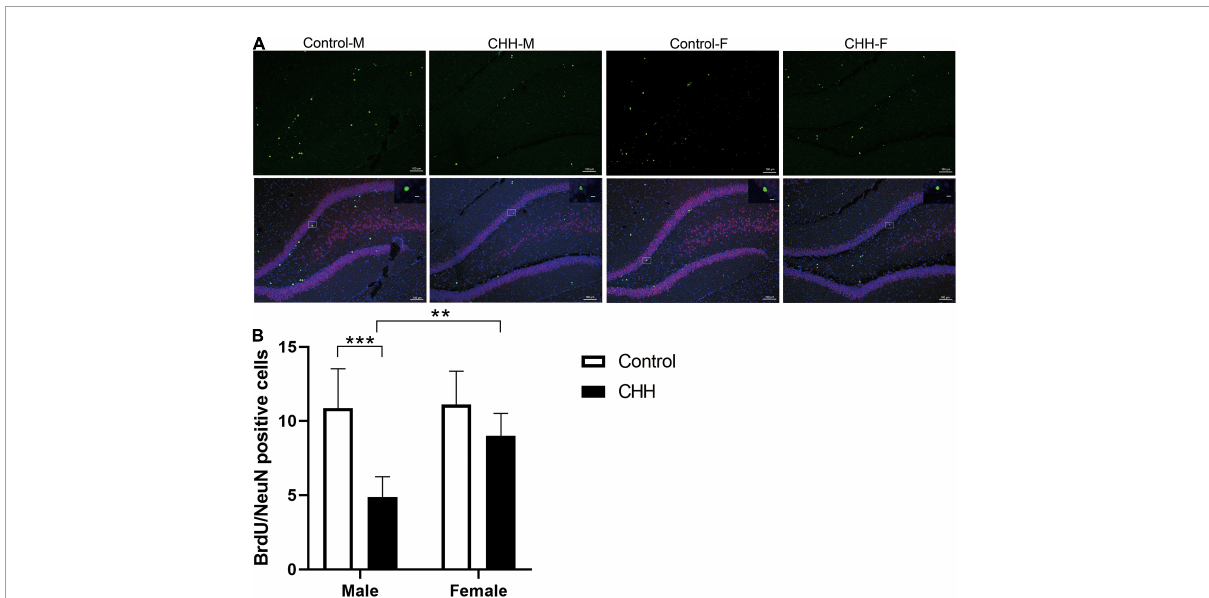
FIGURE7 Effects of CHH on neurogenesis in DG region of female and male rats. (A) Representative NeuN (green) and BrdU (red) staining in the dentate gyrus of brain sections. (B) Quantification of BrdU + /NeuN + cells. Values are means ± SD for six animals/group. Data for male and female rats, with or without CHH exposure, were analyzed using two-way ANOVA. Post hoc analysis indicated: * p < 0.05, ** p < 0.01, *** p <